Question: From the figure, is the trend upward or downward?
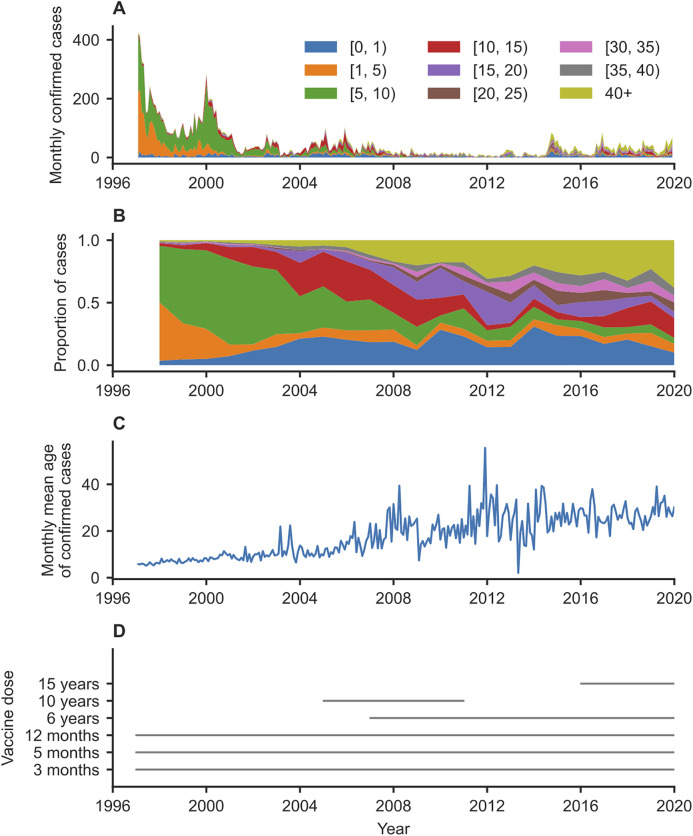
Answer: increasing